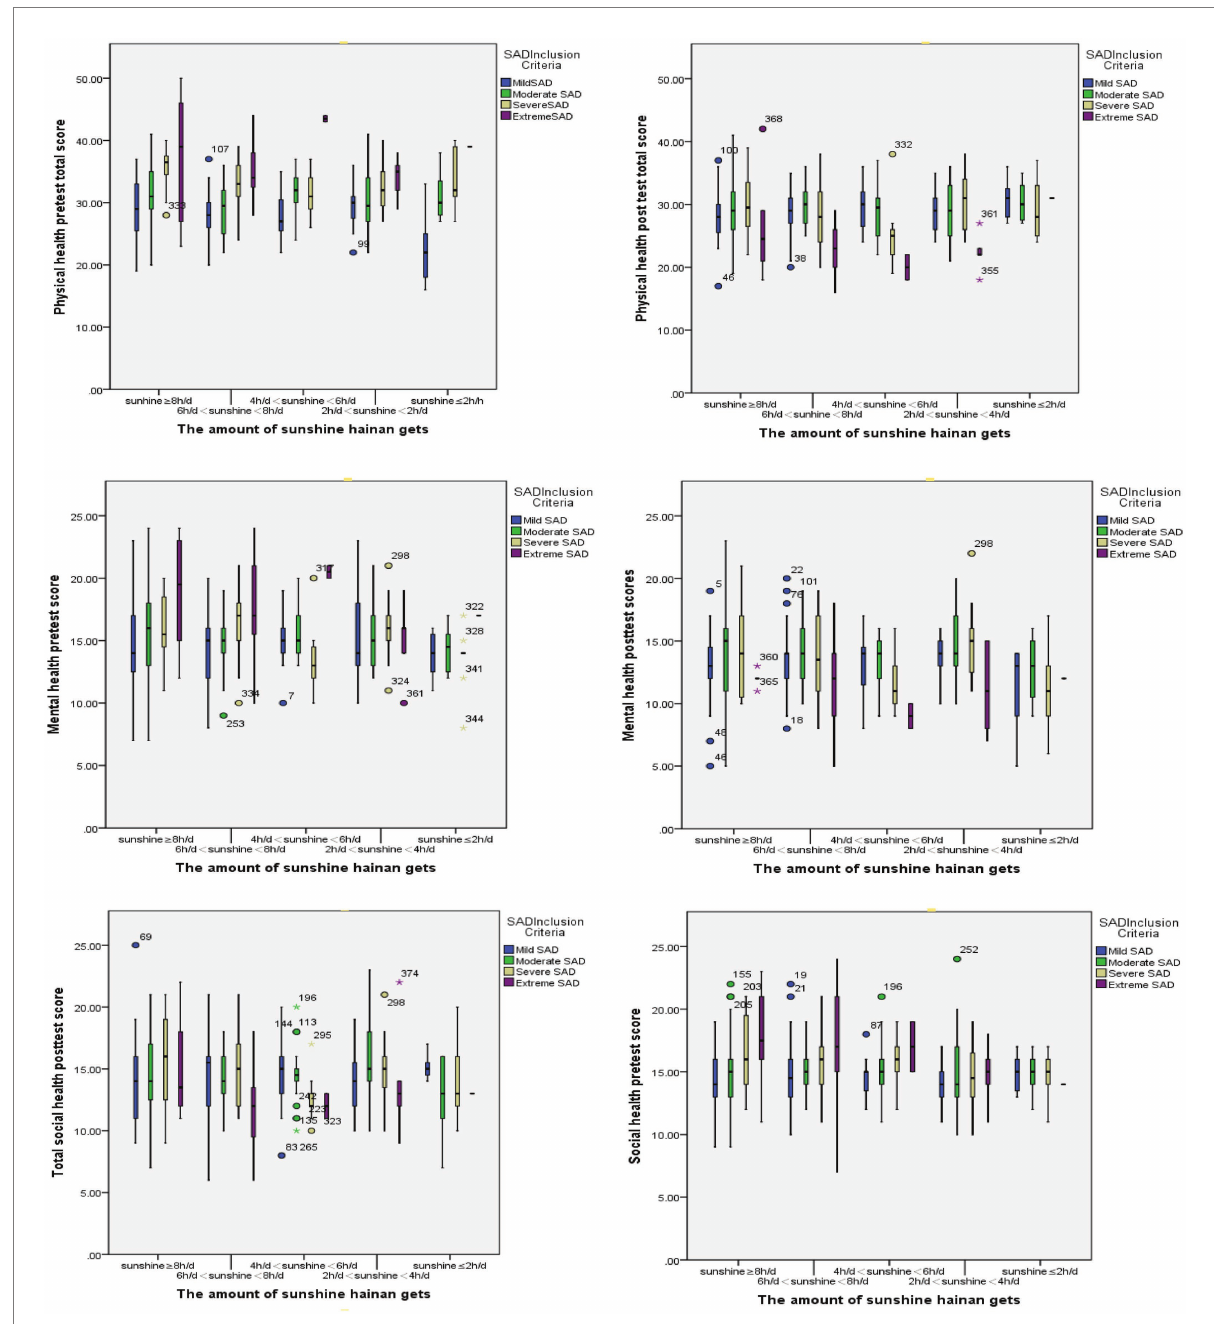
FIGURE 4 The effect observation of different degrees of SAD tourists’ QOL in different sunshine levels Hainan.